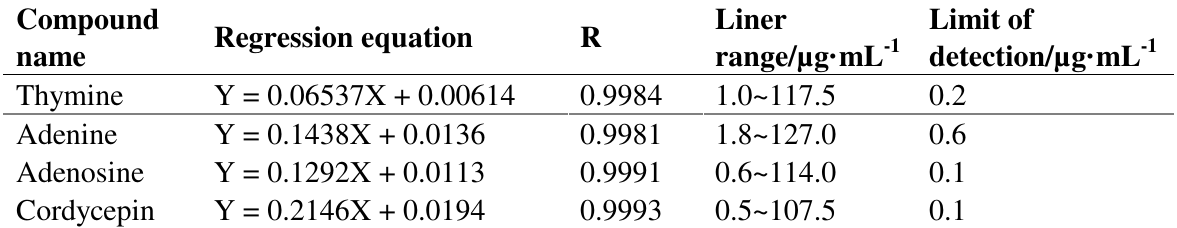
Table 2. Regression equation, correlation coefficients (R), linear range and limit of